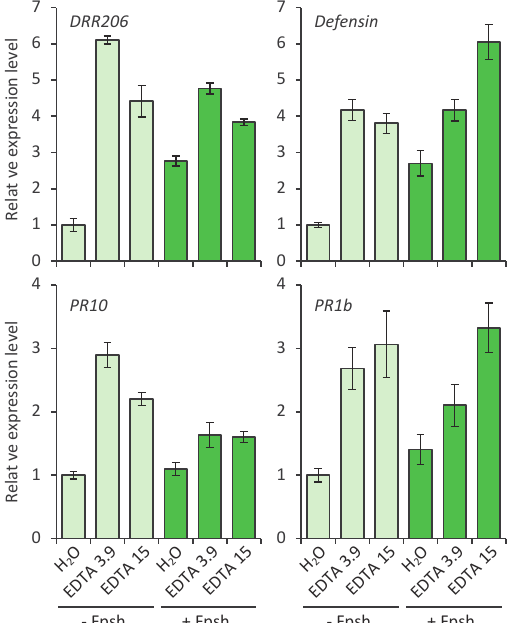
Figure 2. Effect of EDTA treatment on gene expression levels of pea pathogenesis-related genes. Pea endocarp tissues (0.4 g) were treated (20 µL/pod half) for 5 h with water (H 2 O), EDTA 3.9 mM, and EDTA 15 mM and after 20 min with (or without) 5 µL fungal spores (1.3 × 10 6 spores/mL) of, Fusarium solani f. sp. phaseoli (Fsph). The tissues were then subjected to the qRT-PCR analysis. Histograms show the expression levels of pea pathogenesis-related genes. Data were normalized by the reference gene Ubiquitin and converted into a value relative to that of the water treatment control (-Fsph). Error bars represent standard error.